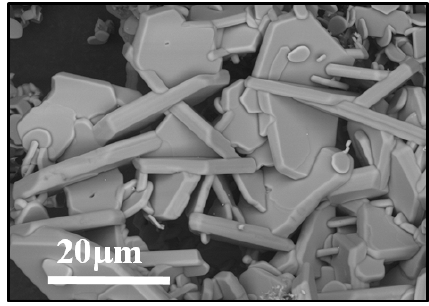
Figure 2. SEM image of Al 4 SiC 4 powders.